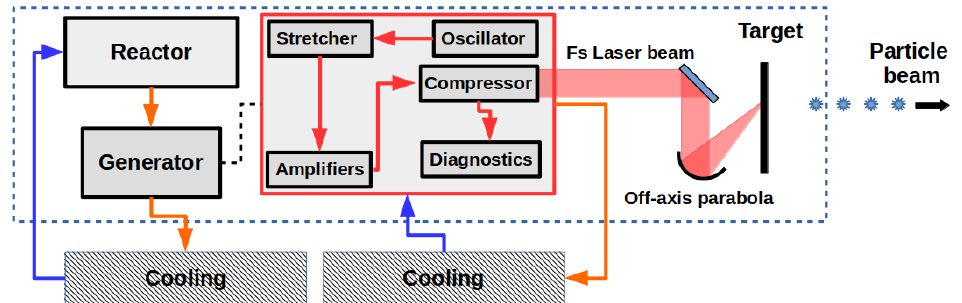
Figure 3. Basic scheme of the Laser-Accelerated Plasma-Propulsion System (LAPPS). The laser system is represented by the red box. LAPPS is a closed cycle